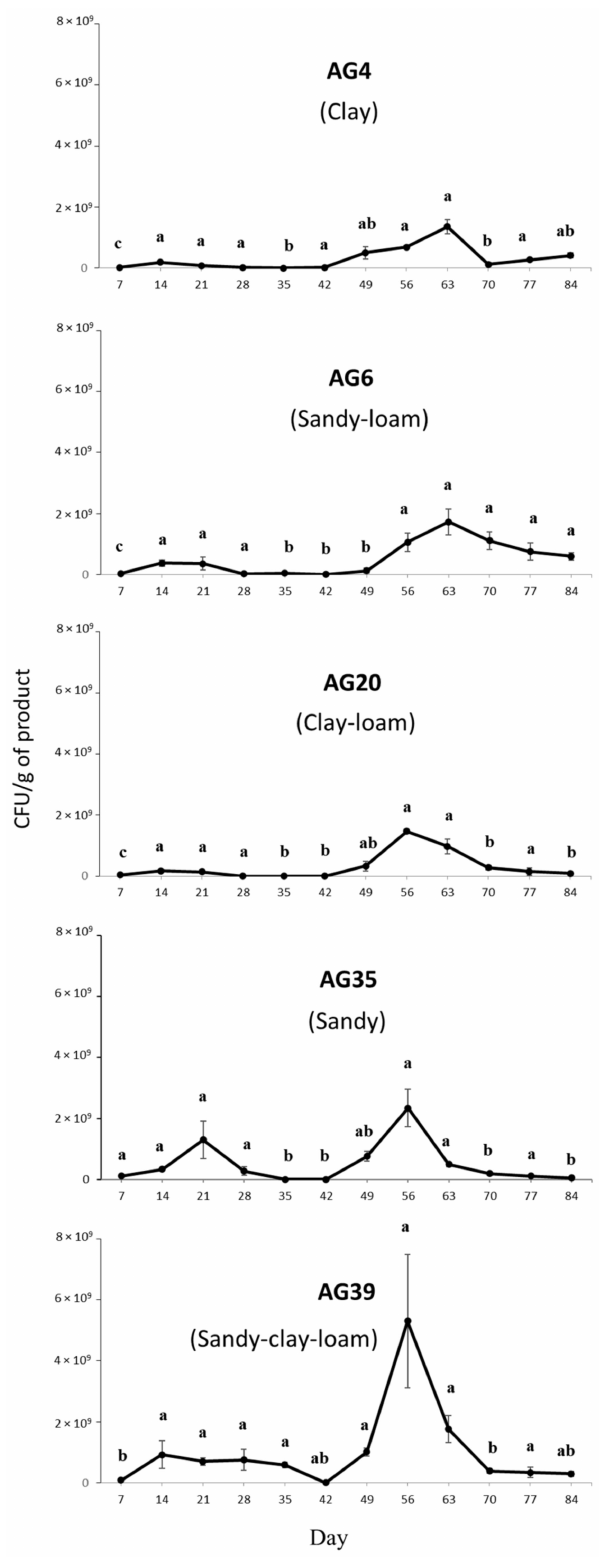
Figure 5. Time course of CFU yield per gram of M. brunneum strain EAMa 01/58-Su microsclerotia, according to the type of soil, over a period of 3 months. Mean values ( ± SE) within the evaluation period (days) followed by different letters are significantly different to one another according to Fisher’s protected Tukey’s HSD test ( p ≤